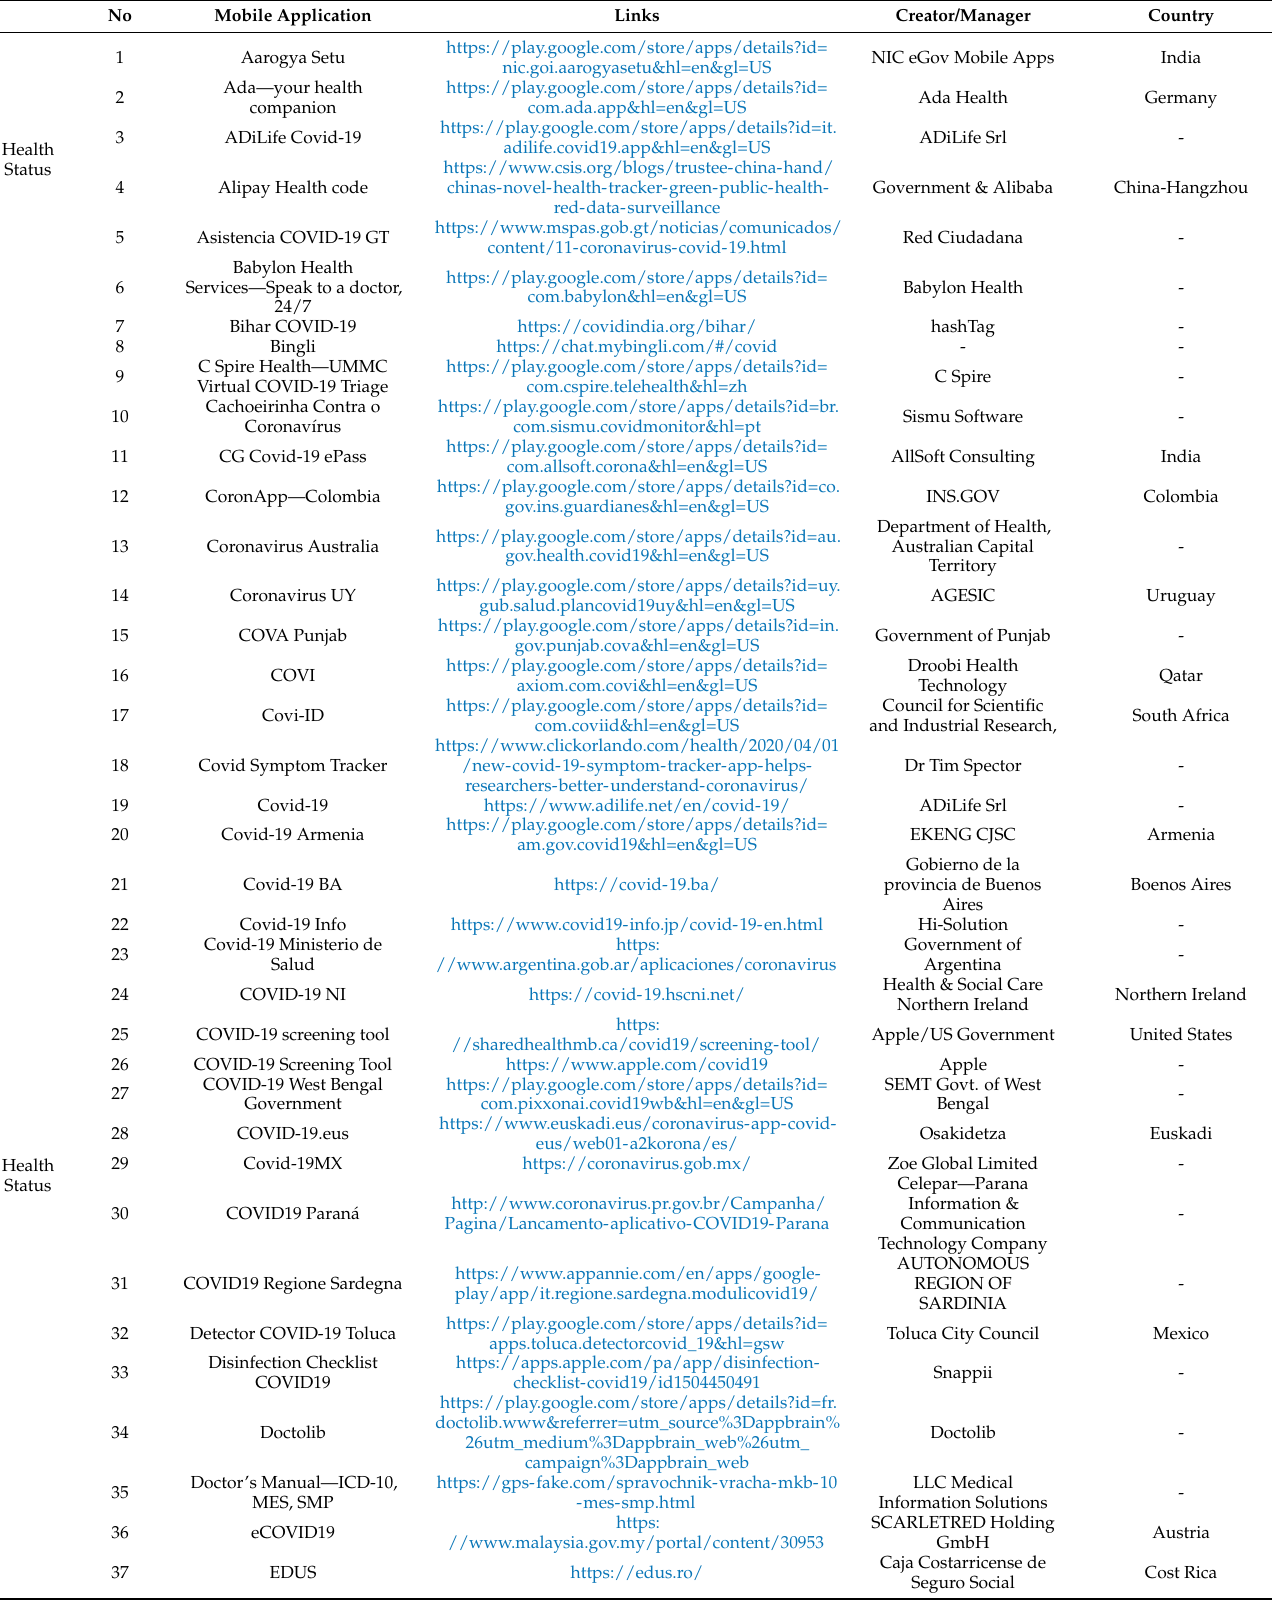
Table A1. List of COVID-19 Location-Based Mobile Applications utilized in the study (accessed March to June